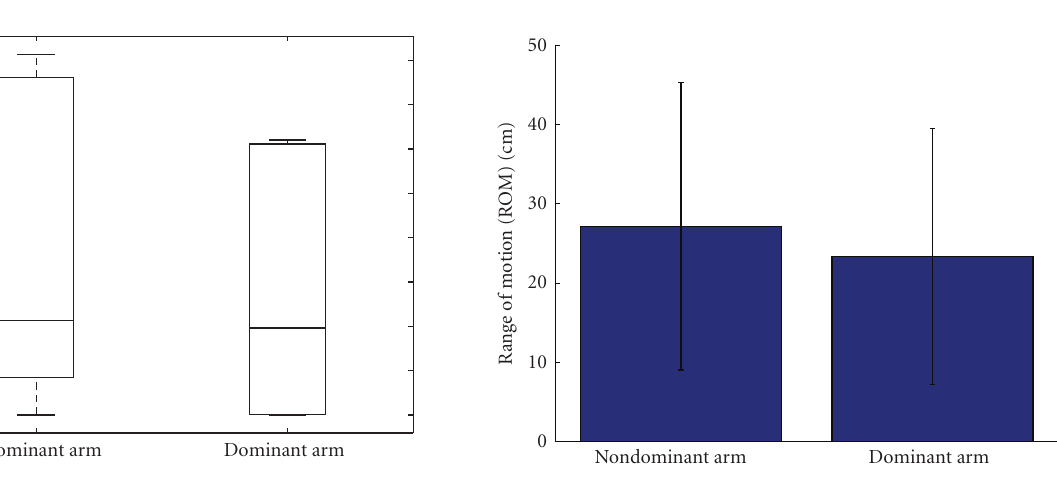
Figure 8: Range of Motion (ROM) usage during NTT training. Data consist of 404 data samples from the 10 healthy participants. Bar indicates mean ROM and error bars